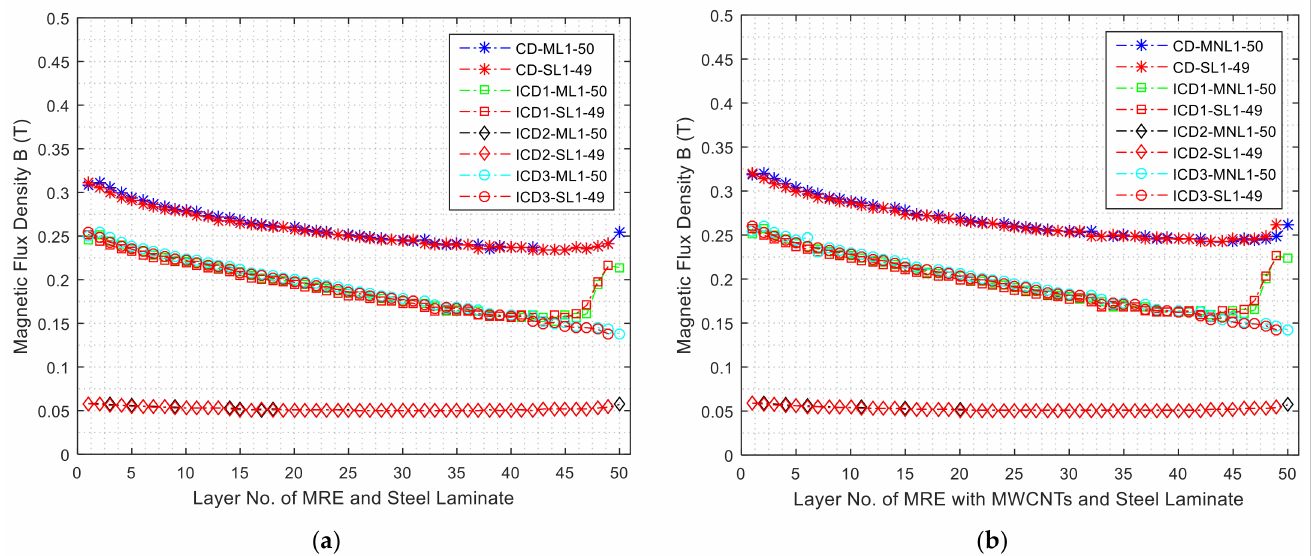
Figure 14. Magnetic Flux Density for Different Design Schemes, ( a ) MRE and Steel Laminate, ( b ) MRE with MWCNTs and Steel